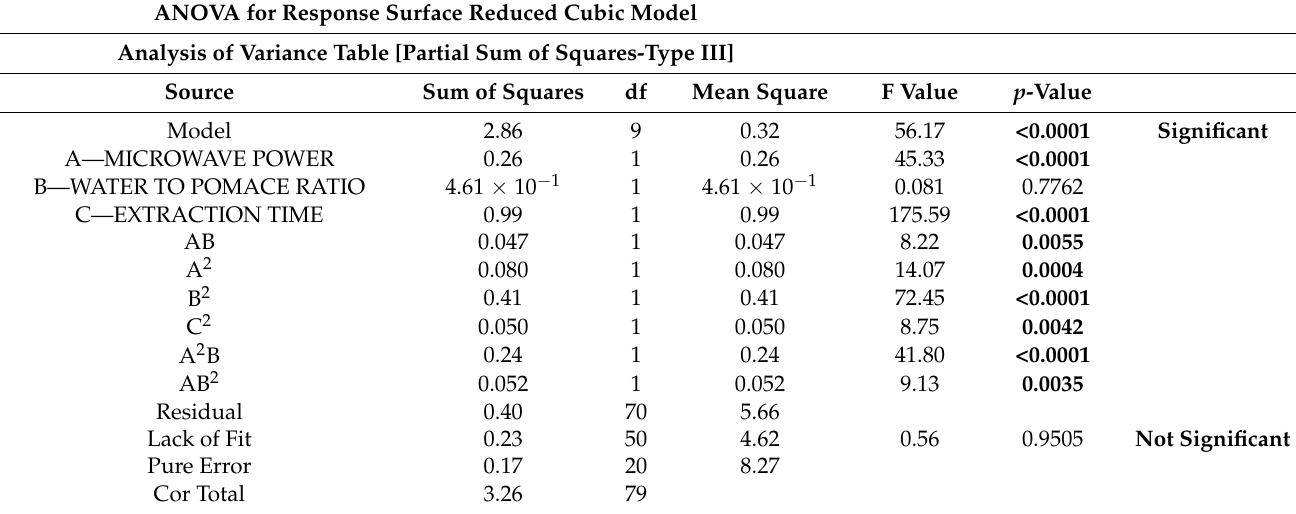
Table 6. ANOVA for reduced cubic RSM model of OP total flavonoids productivity. ANOVA for Response Surface Reduced Cubic Model Analysis of Variance Table [Partial Sum of Squares-Type